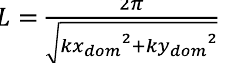
Figure 2. Poteran Island Location